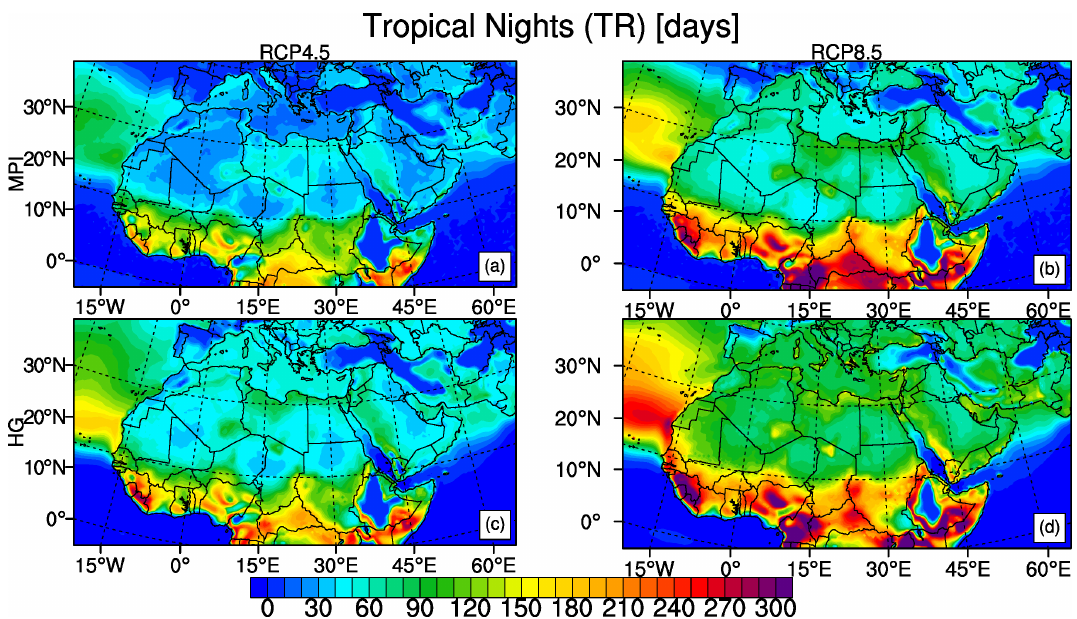
Figure 4. The temporally averaged changes in TR for the period of 2071–2100 displayed as differences (in days) with respect to the reference period 1971–2000 for the model MPI-ESM-MR with RCP4.5 ( a ) and RCP8.5 ( b ) and for the model HadGEM2-ES with RCP4.5 ( c ) and RCP8.5 ( d